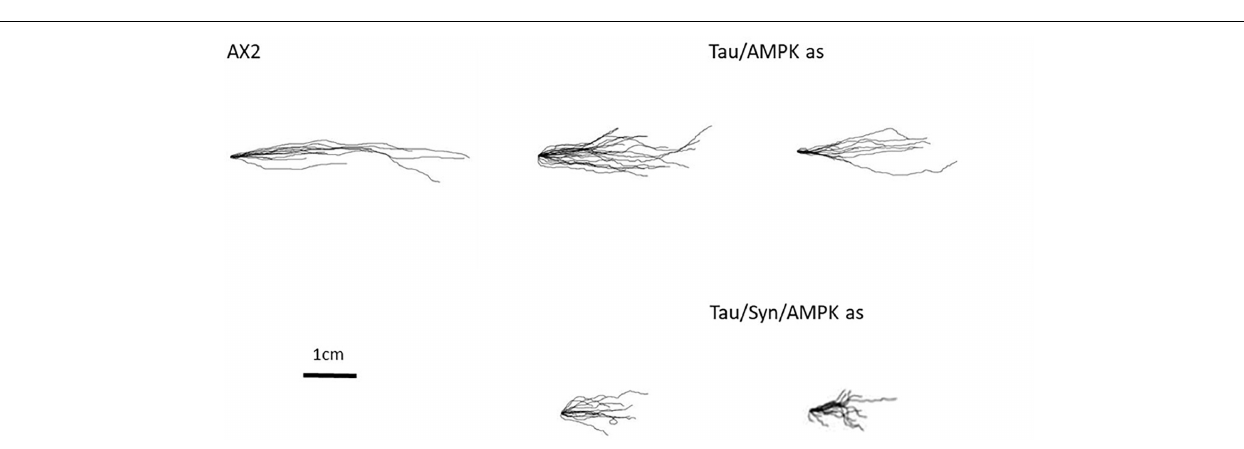
FIGURE 6 | Aberrant phenotypes associated with mitochondrial disease are rescued with antisense inhibition of AMPK. The phototaxis defect is rescued by the knockdown of AMPK. Cotransformants expressing tau and antisense AMPK (Tau/AMPK) rescues the phototaxis defect of tau. The more severe defect that was seen with tau and α -synuclein expression combined was also rescued by antisense inhibition of AMPK (Tau/Syn/AMPK) and strains resemble the